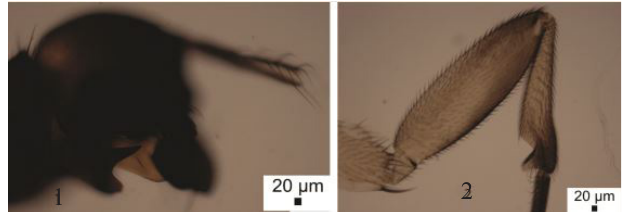
Figs 1-2. Apterophora bragancai male.1, left face of hypopygium; 2, front tibia.